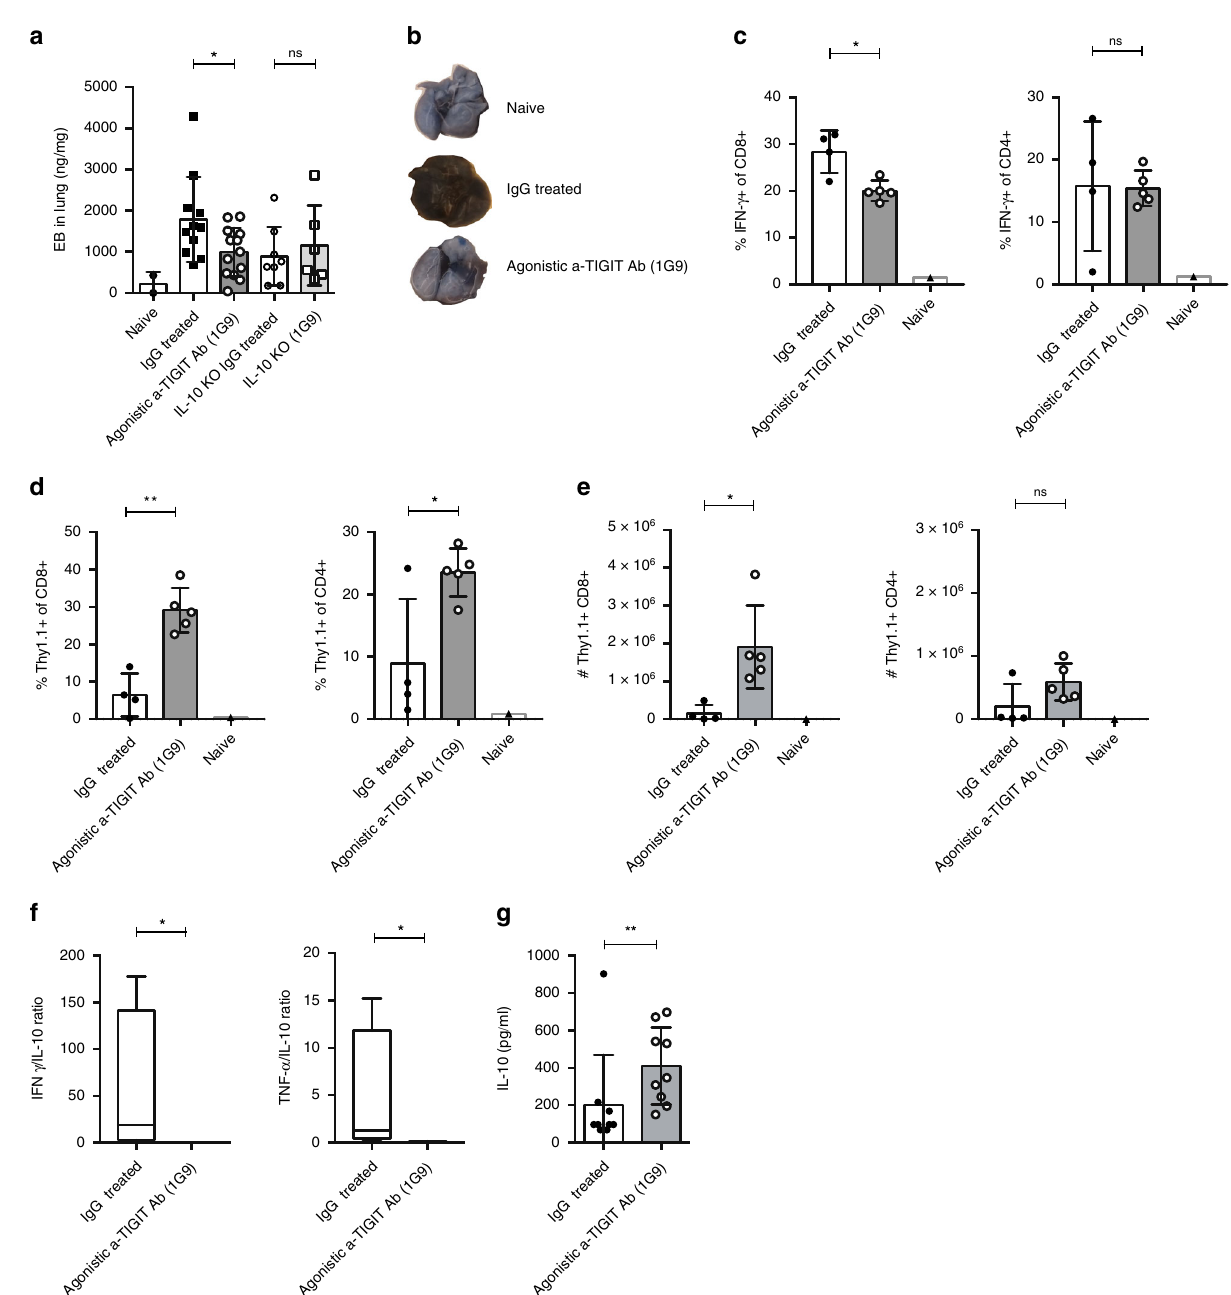
Fig. 7 TIGIT stimulation protects from lung vascular leakage after in fl uenza infection. C57BL/6 mice and IL-10 KO mice were infected with 150 PFU PR8 virus i.n. and treated with 100 μ g of control IgG1 or anti-TIGIT Ab (1G9) on days 0, 2, and 4 i.p. Evans blue (EB) dye was injected i.v. on day 8 p.i., followed by lung perfusion with PBS. a Colorimetric quanti fi cation of EB extravasation from the lung. The mean EB concentration in the lungs was normalized to the weight of the organ ( n = 6 – 16). b Representative pictures of PBS perfused lungs of naive WT mice or mice with and without anti-TIGIT (1G9) Ab treatment on day 8 p.i. are shown. c – f The T cell phenotype was assessed on day 8 p.i. in the lung of IgG1 and anti-TIGIT (1G9) Ab-treated mice by FACS. c Frequency of IFN- γ + CD8 + and CD4 + T cells. d Frequency of IL-10-Thy1.1 + CD8 + and CD4 + T cells. e Absolute numbers of IL-10-Thy1.1 + CD8 + and CD4 + T cells and ( f ) the ratio of total IFN- γ + to IL-10 + CD8 + T cells and TNF- α + to IL-10 + CD8 + T cells are displayed ( n = 4 – 5). g IL-10 protein levels were measured in whole-lung homogenates by cytometric bead assay ( n = 9). Each symbol in the scatter plot represents an individual mouse and bar graphs indicate the mean value ± SD. Statistical values p < 0.05 (*), p < 0.01 (**), p < 0.005 (***), ns (not signi fi cant, p > 0.05) determined by Student ’ s t test (two experimental groups) or one-way ANOVA (more than two experimental groups). Cytokine ratio data were evaluated using two-tailed Mann – Whitney effector function 34,43 . We found that antibody-mediated TIGIT blockade during chronic LCMV infection resulted in marked downregulation of other co-inhibitory receptors, such as PD-1, Chronic LCMV infection represents the prototypic model to Tim-3, and Lag-3 on total CD8 + T cells and on CD4 + T cells. In contrast to CD8 + T cells, where co-inhibitory receptor expression several inhibitory receptors marks T cells with diminished